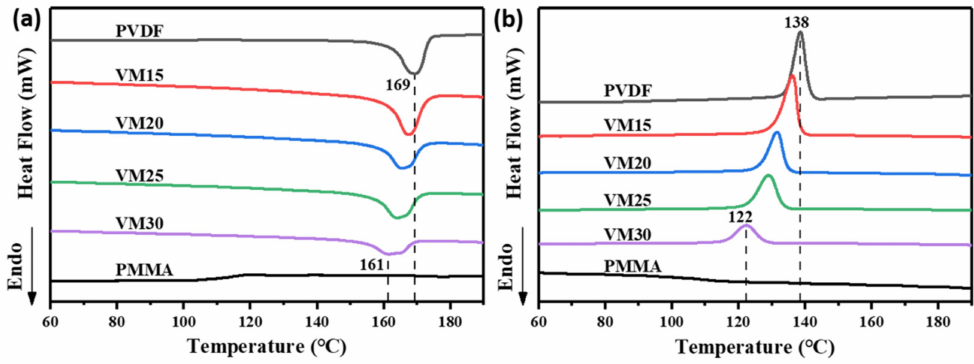
Figure 2. DSC ( a ) heating and ( b ) cooling thermograms of PVDF, PVDF/PMMA blend VM and